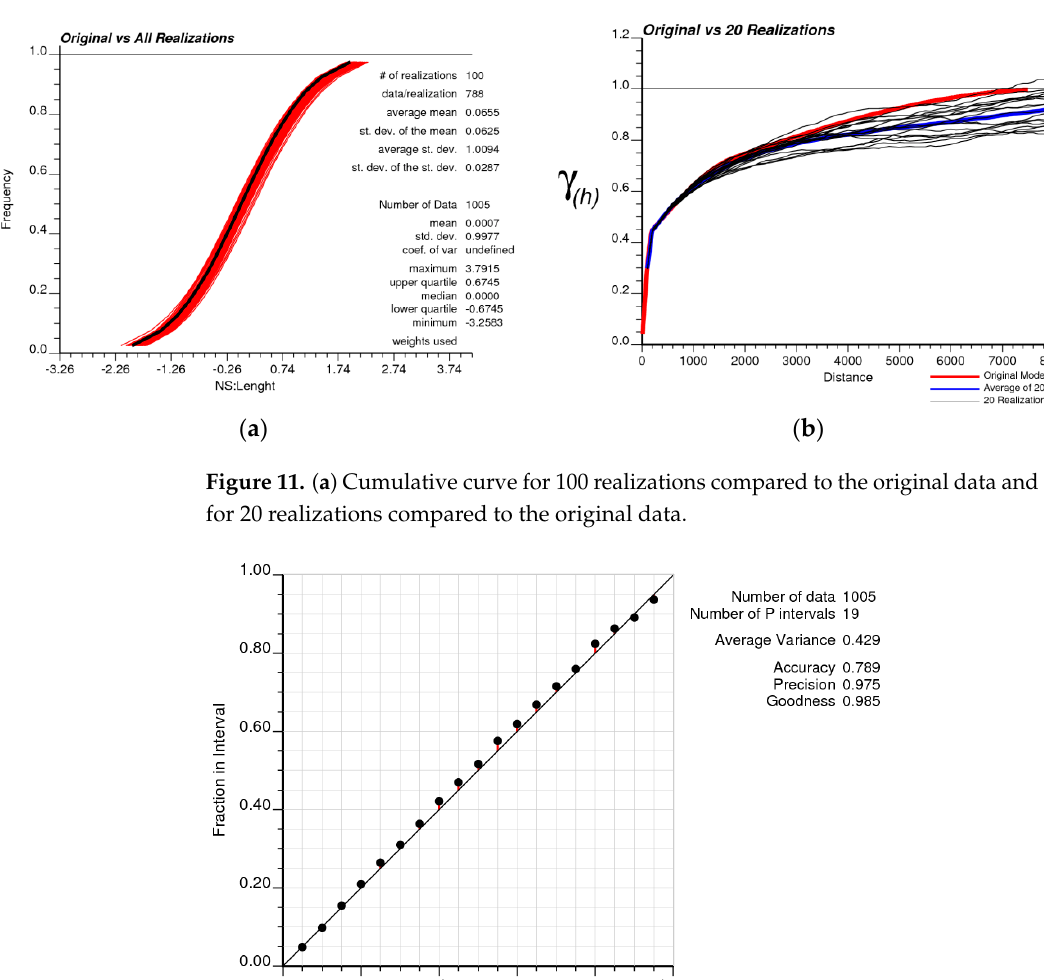
Figure 12. Accuracy check of the outputs.